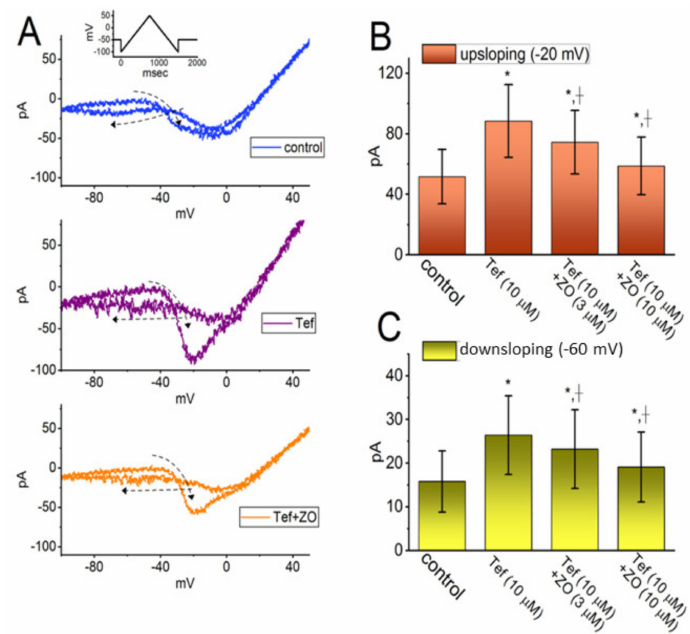
Figure 2. Inhibitory effect of ZO on Tef-mediated augmentation in persistent I Na ( I Na(P) ) activated by a double ramp pulse in GH 3 cells. In this set of whole-cell current recordings, we held the potential applied to the examined cell at − 50 mV, and a triangular ramp voltage with a duration of 1.5 s (i.e., a ramp speed of ± 0.2 mV/msec) was applied to elicit I Na(P) . That is, the whole-cell currents